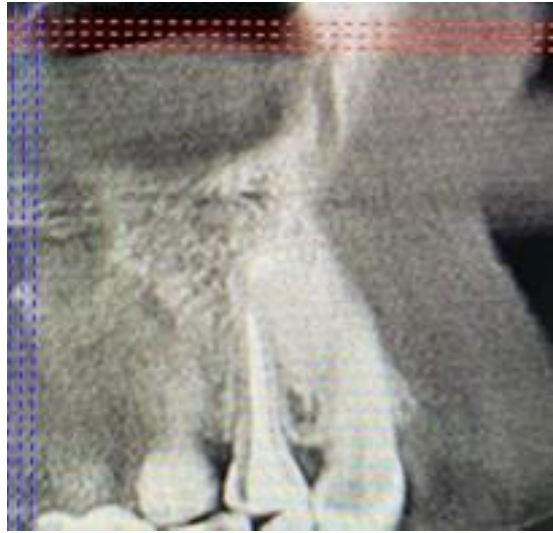
Figure 12. CBCT sagittal view after 15 months.